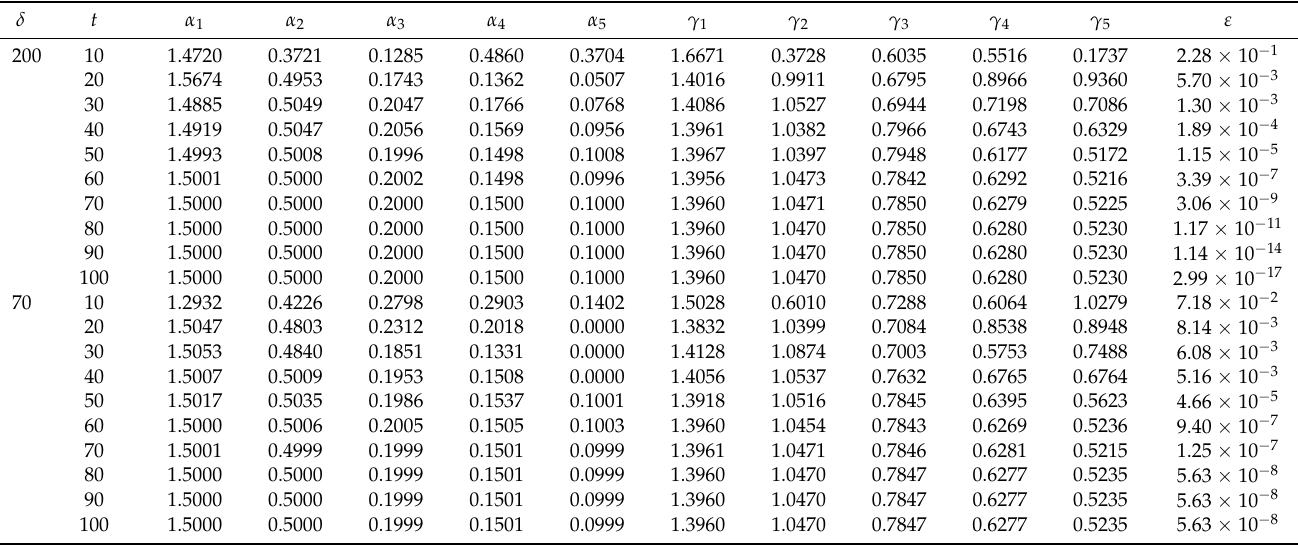
Table 3. Fitness results along with the estimated values for λ =